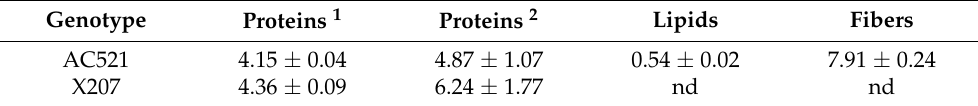
1 Protein concentration calculated as the total amount of amino acids determined after protein digestion minus the free amino acids determined in similar samples. 2 Protein concentration calculated using the N to protein conversion factor of 5.1 [17]. nd, not